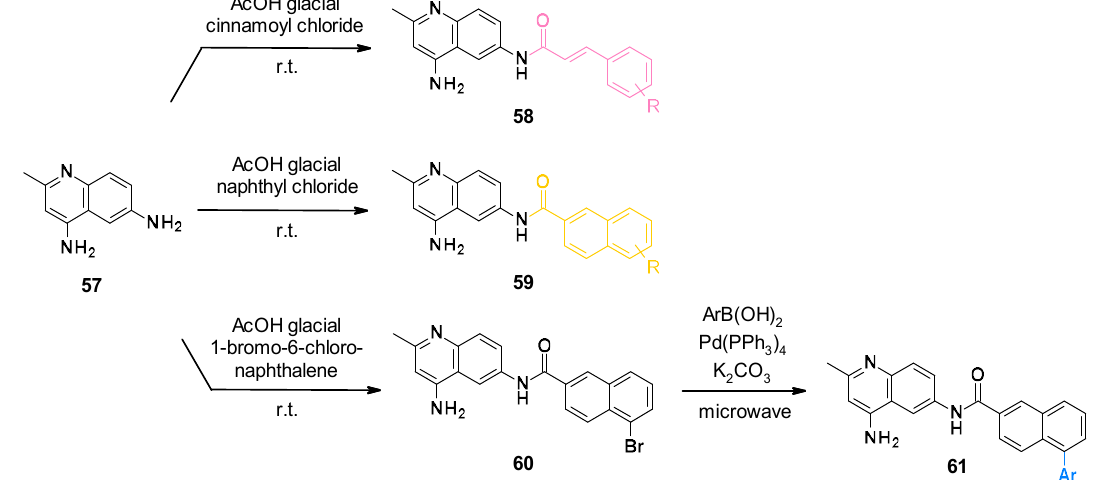
Scheme 6. Chemical synthesis of NSC-33353-derived